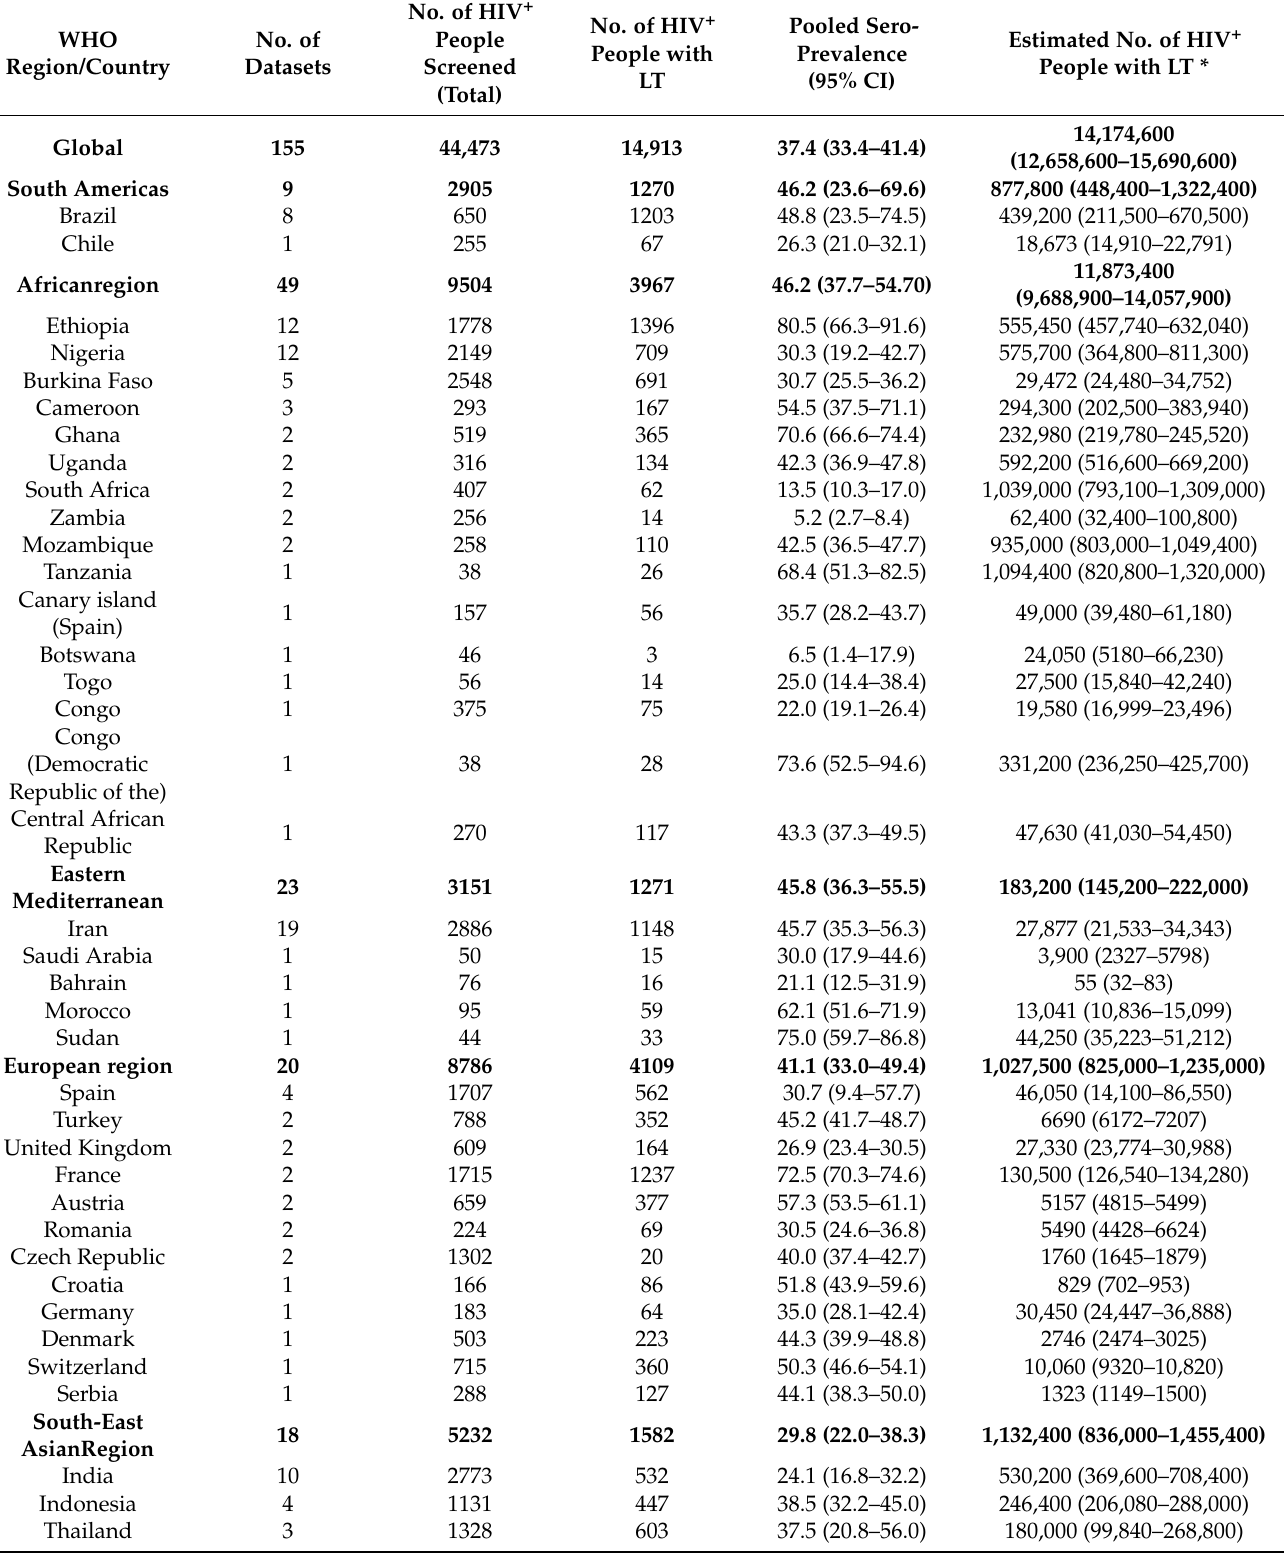
Table 1. Global, regional and national pooled seroprevalences of latent T. gondii infection (LT) in HIV + people (results from 155 datasets performed in 48